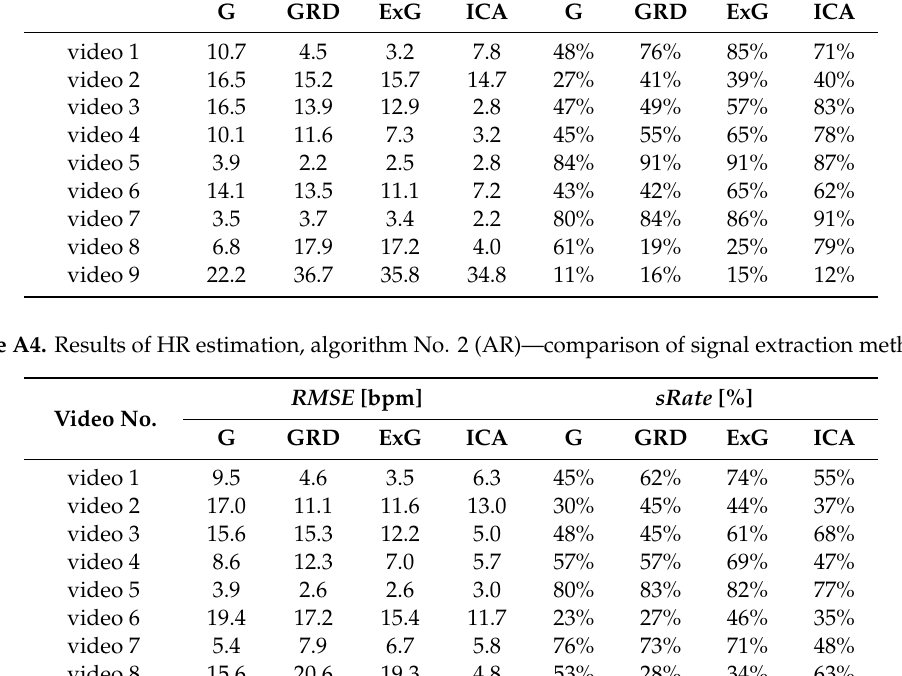
Table A3. Results of HR estimation, algorithm No. 1 (PSD)—comparison of signal extraction methods. Video No.